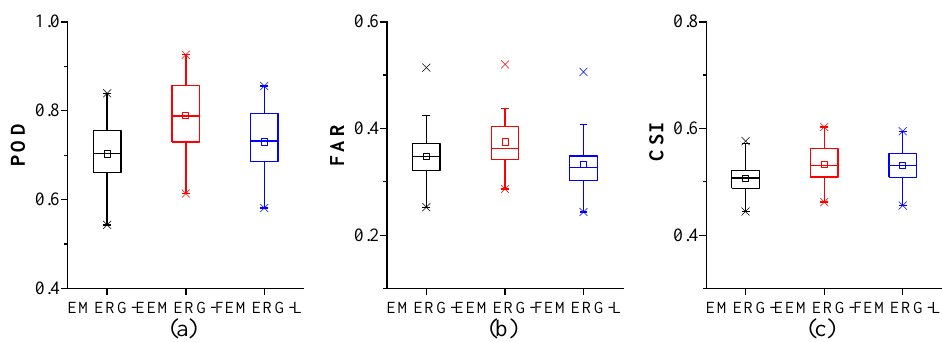
Figure 10. Boxplot of statistical indices (( a ): POD, ( b ): FAR, ( c ): CSI) for precipitation events detected by the IPPs based on a 1 mm/d precipitation threshold. The three lines from the bottom to the top of each box represent the 25th, 50th, and 75th percentile, respectively. The crosses represent the minimum and maximum values, and the small rectangle indicates the mean value.